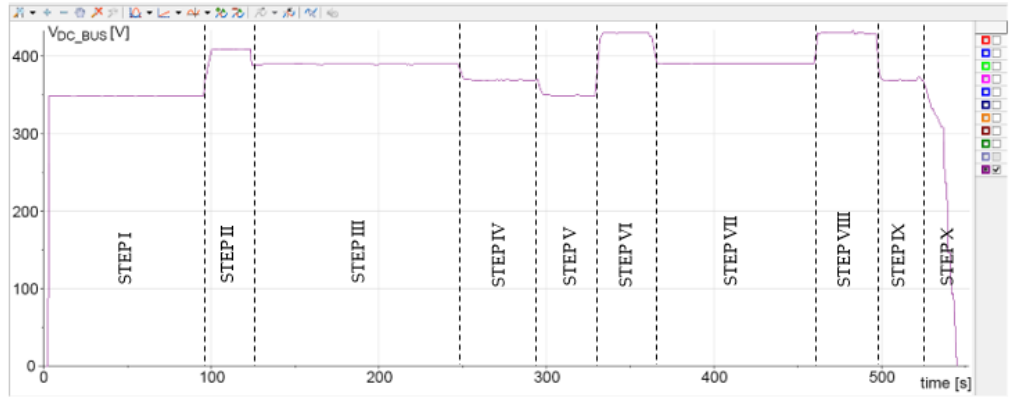
Figure 8. DC bus Voltage of the Smart User Network (SUN).